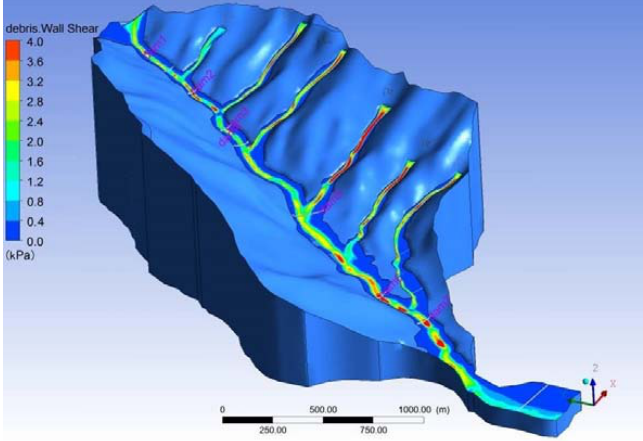
Figure 9. Debris flow shear stress on the riverbed wall (time = 1634.2 s).